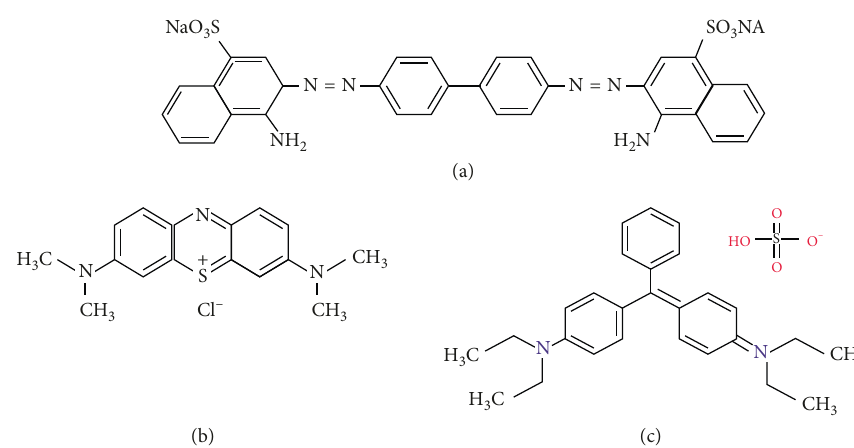
Figure 1: Chemical structure of dyes: (a) Congo Red, (b) Methylene Blue, and (c) Brilliant Green.